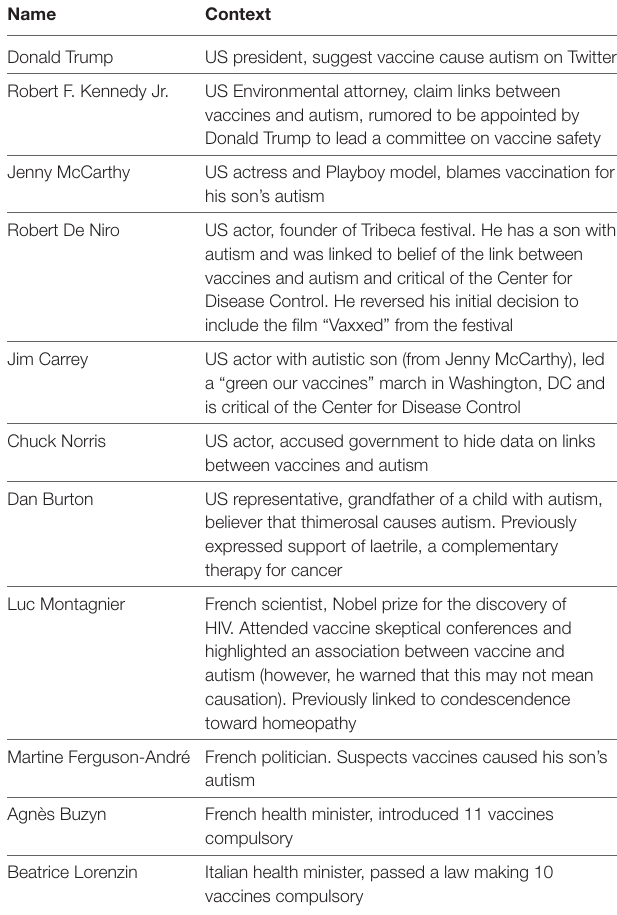
Table 5 | Celebrities most mentioned in the search engine result pages.